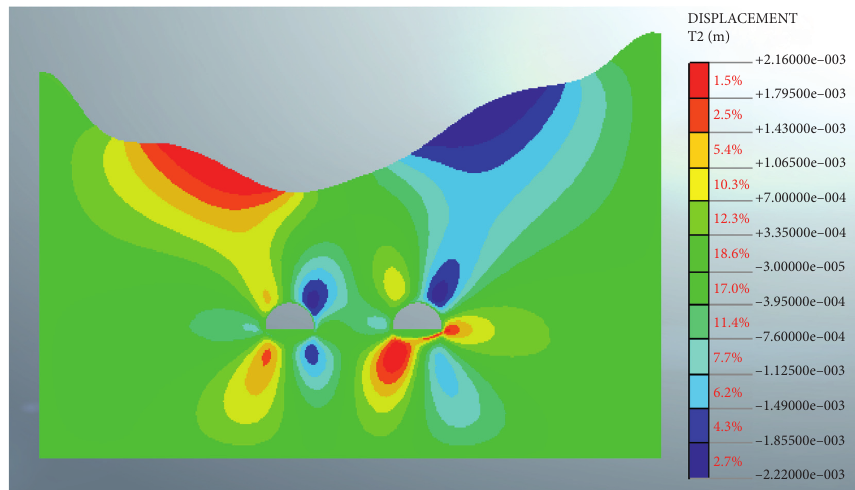
Figure 21: Horizontal displacement distribution of surrounding rocks by single-side guide pit